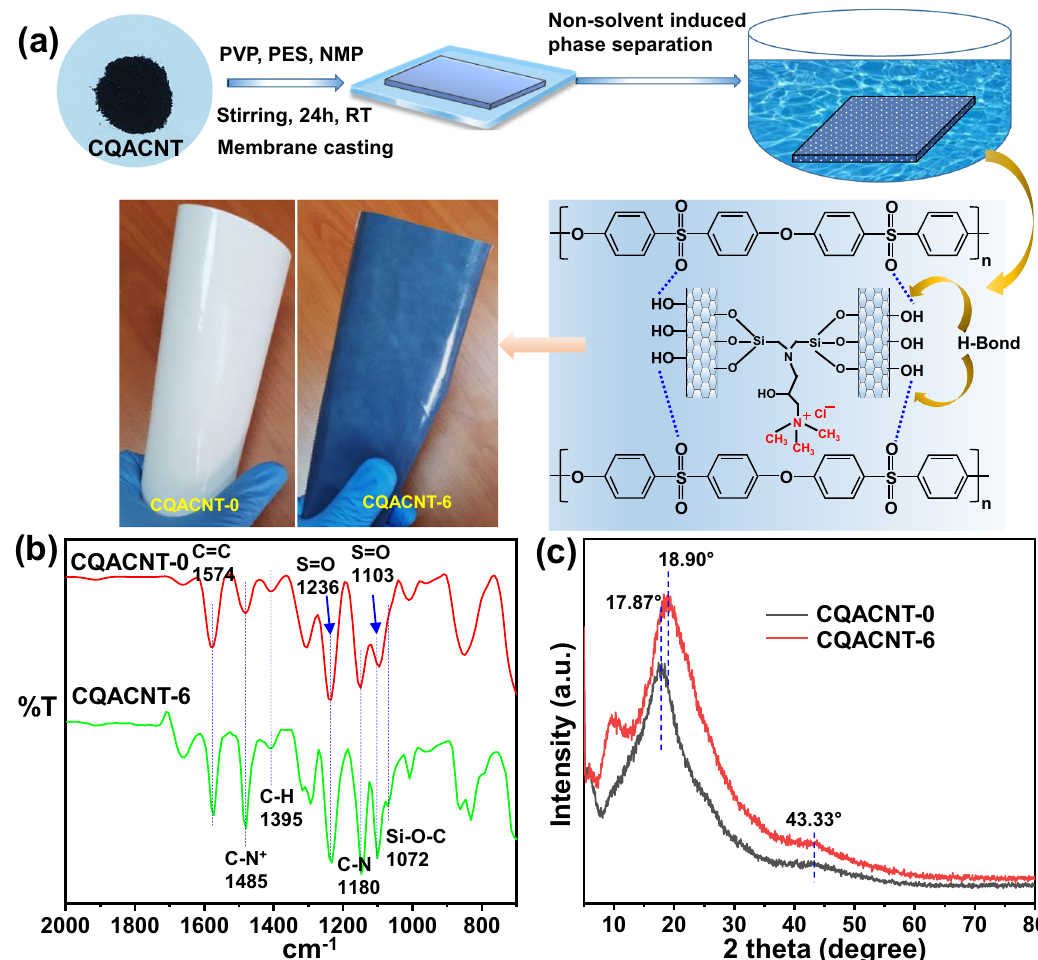
Fig. 3 Membrane fabrication and chemical characterization. a Membrane fabrication process, chemical structure of the membrane, possible interactions between PES and CQACNT, and optical images of the pristine CQACNT-0 and CQACNT-6 membranes; b FT-IR spectra of the CQACNT-0 and CQACNT-6 membranes; c Powder XRD patterns of the CQACNT-0 and CQACNT-6